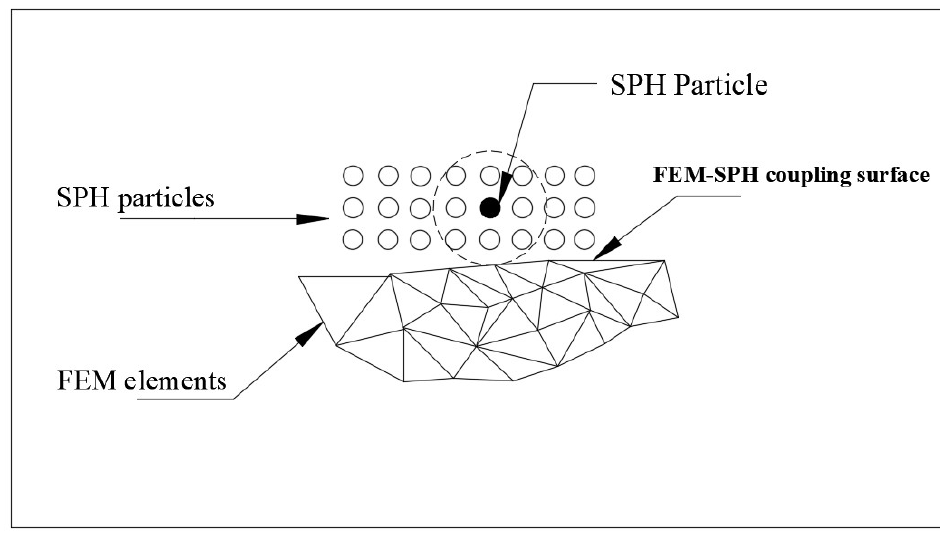
Figure 2. The contact model between FEM and SPH.